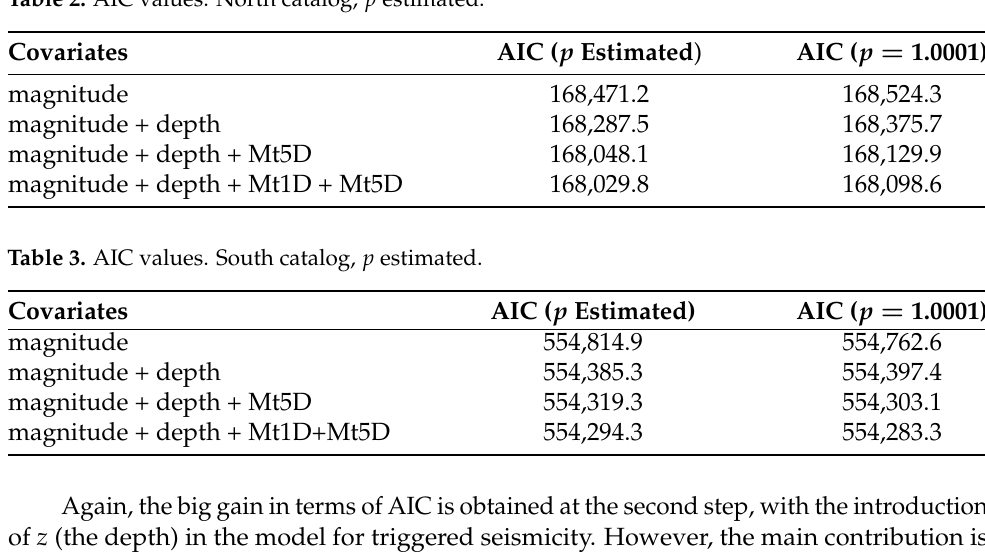
Table 2. AIC values. North catalog, p estimated.